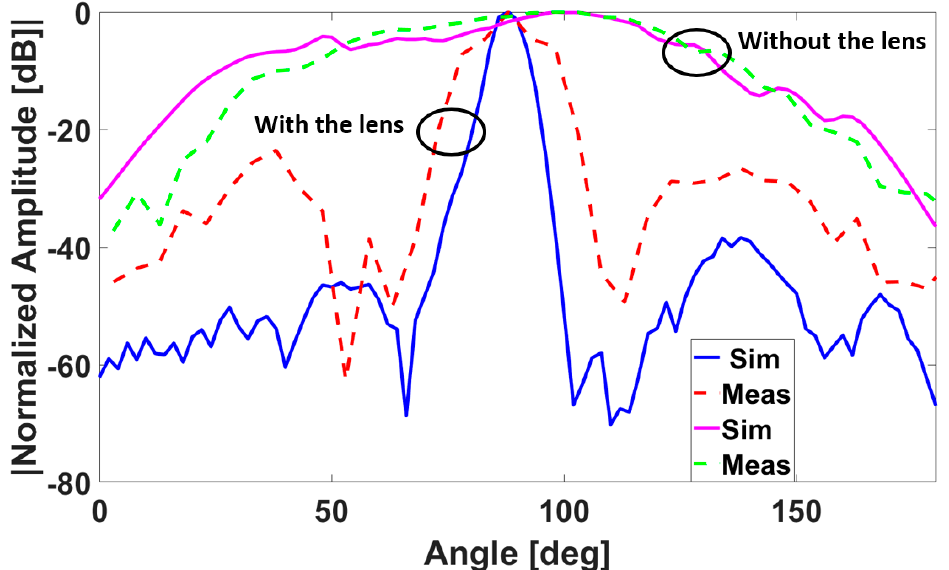
Figure 2. Simulated and measured patterns of the radar received power by the radar receiver Rx1 transmitted by Tx1 integrated with and without the lens.